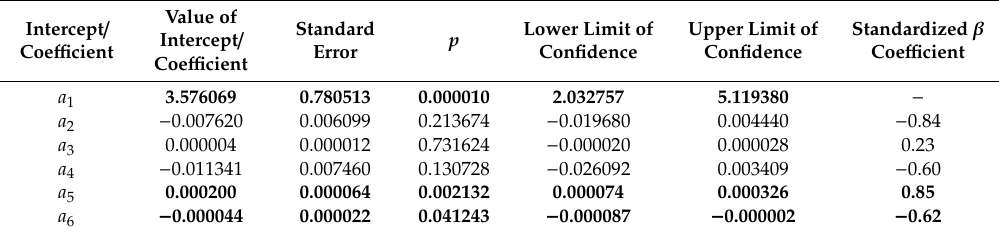
Table A4. Statistic evaluation of 3D model parameters of H:C (model